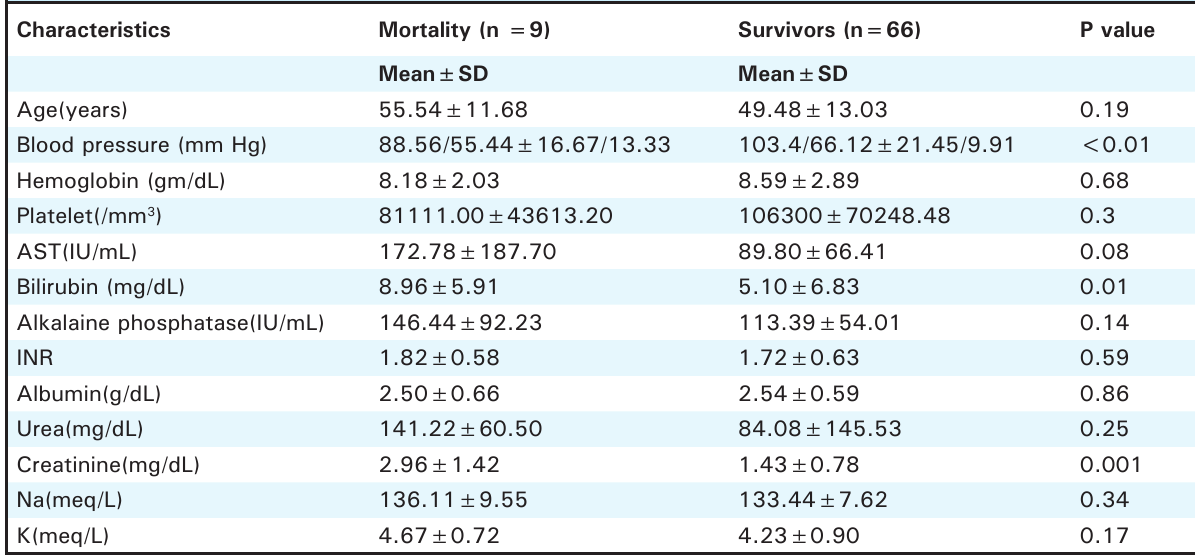
Table 1. Baseline characteristics of the